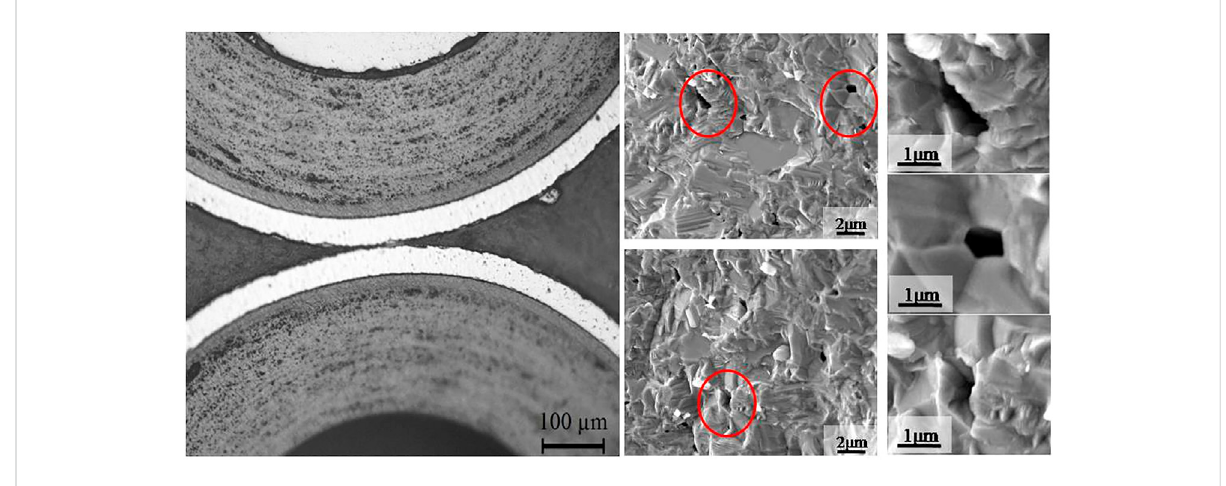
FIGURE 2 Microstructure of typical pores in the SiC layer.